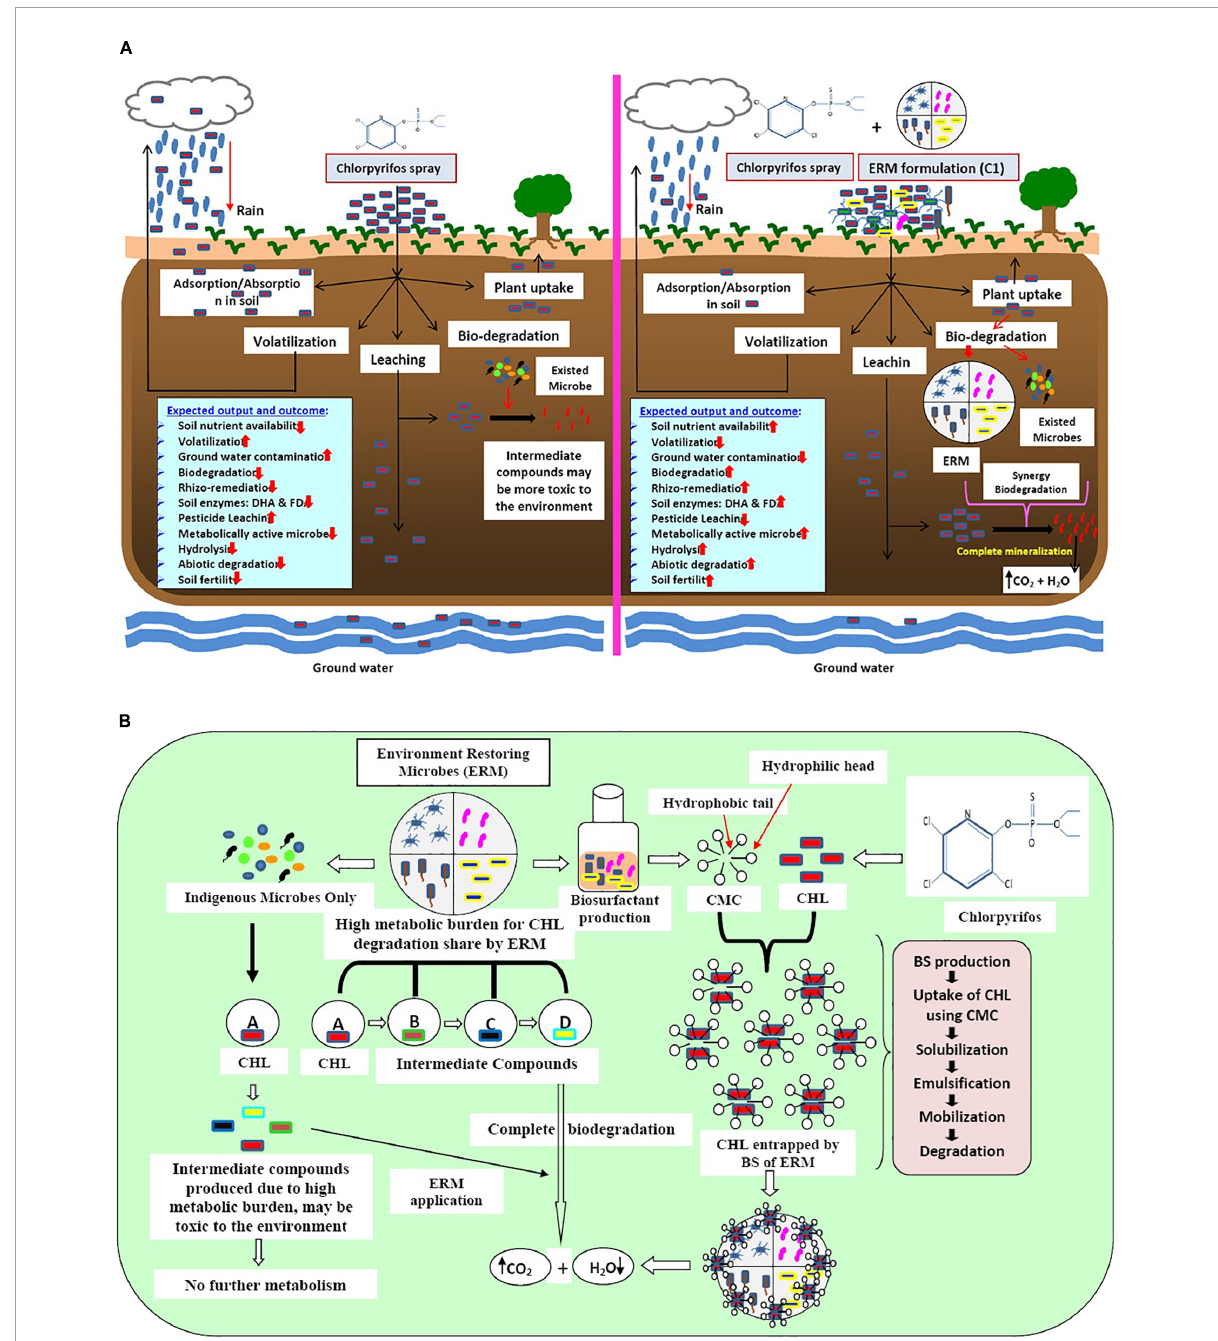
FIGURE6 (A ) Schematic diagram of the impact of pesticide (chlorpyrifos) and microbes (ERM- environment restoring microbes-C-1 formulation and already exited microbes) on soil, plant, and environment. (B) Mechanisms of action of bio-surfactant producing environment restoring microbes (ERM) in chlorpyrifos (CHL)